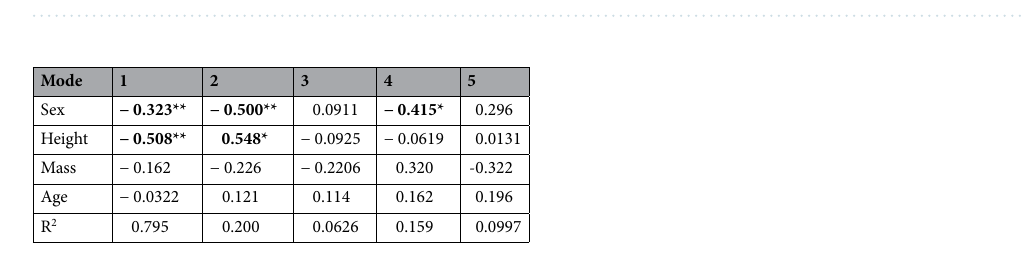
Table 2. Standardised coefficients (beta) of multiple linear regression for modes in the SSFM. * , **Significance at the 95% and 99% level,